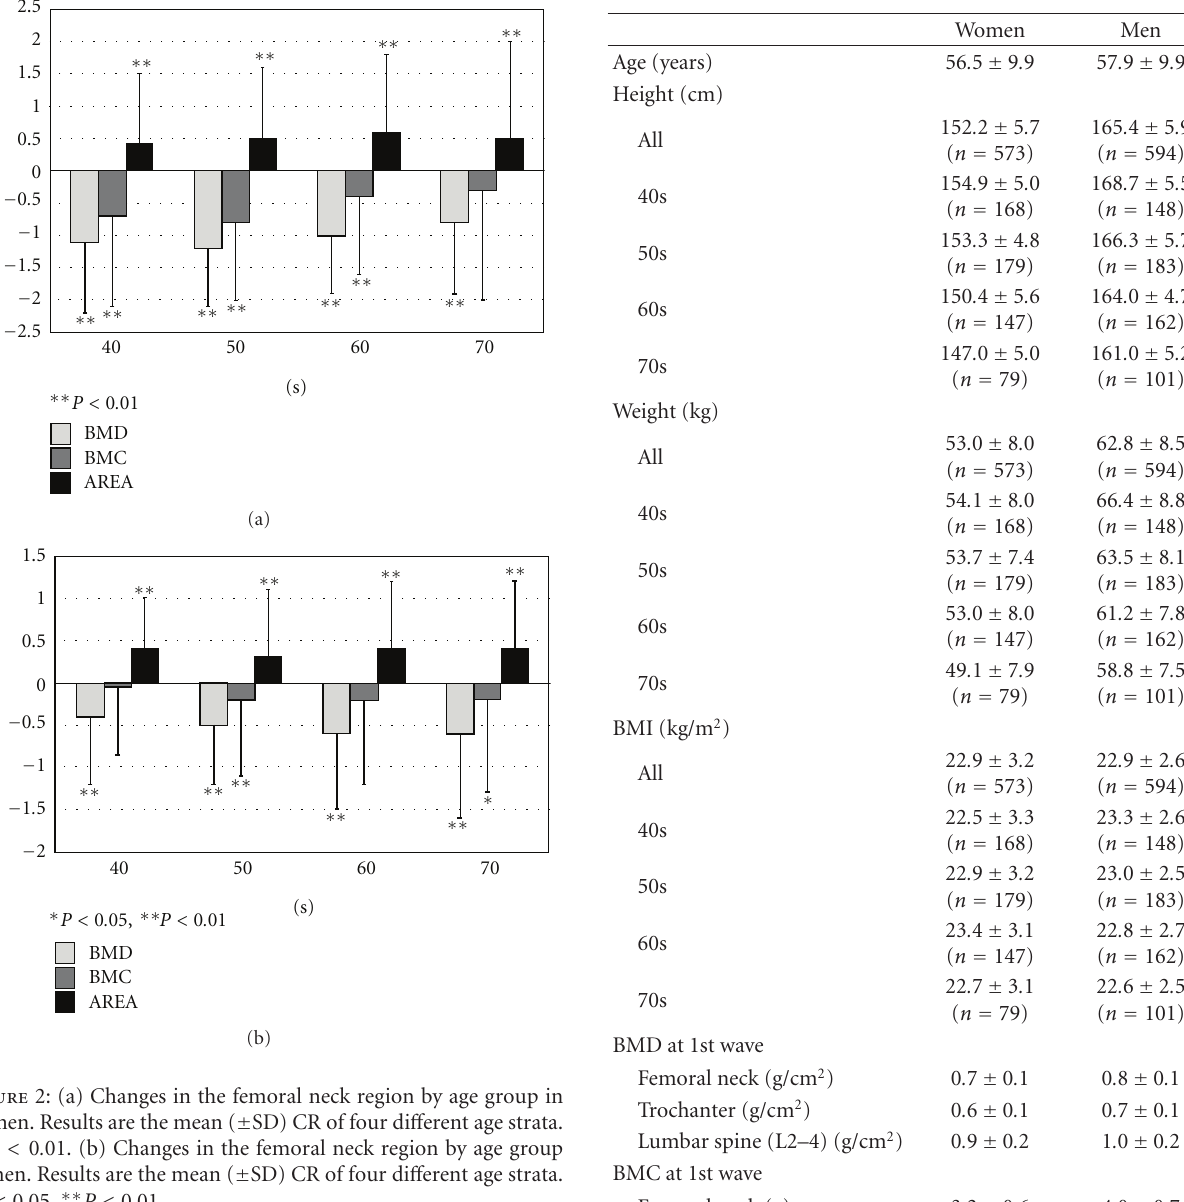
the significant increase of BMC (0 . 5 ± 1 . 0% in 50s, 1 . 0 ± 3 . 4%